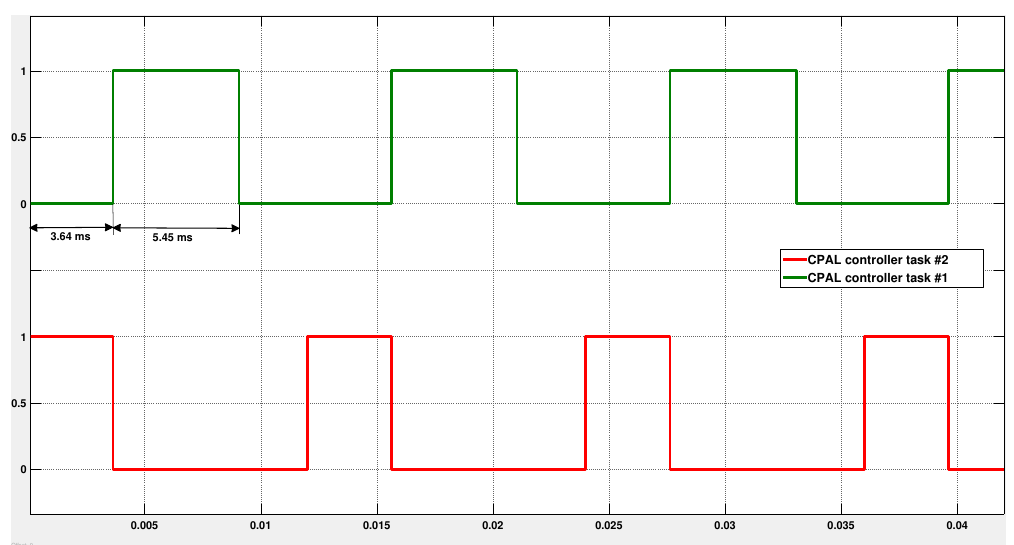
Figure 8. Successive activations of two tasks under FIFO. Task 1 is the controller we design with a period of 12 ms. Task 2 is the cruise control manager also with a 12 ms period. As Task 2 is of higher priority, it is activated first when both tasks are released simultaneously. Using varying execution time annotations for Task 1 and Task 2, we enforce an input-to-output delay of at most 9.09 ms for Task 1, which is the bound obtained from jitter margin